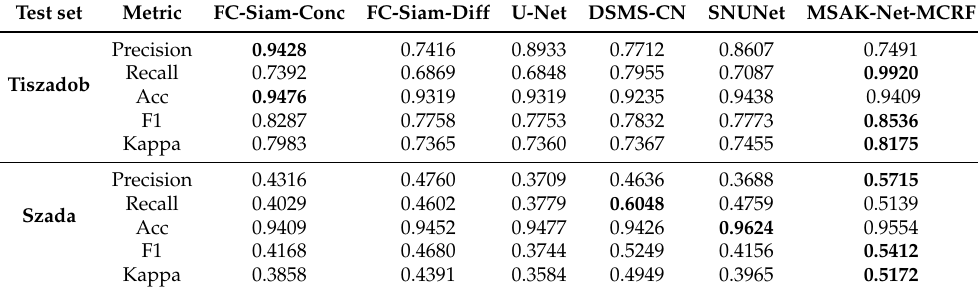
Table 2. Experimental results of state-of-the-art methods on SZTAKI dataset.